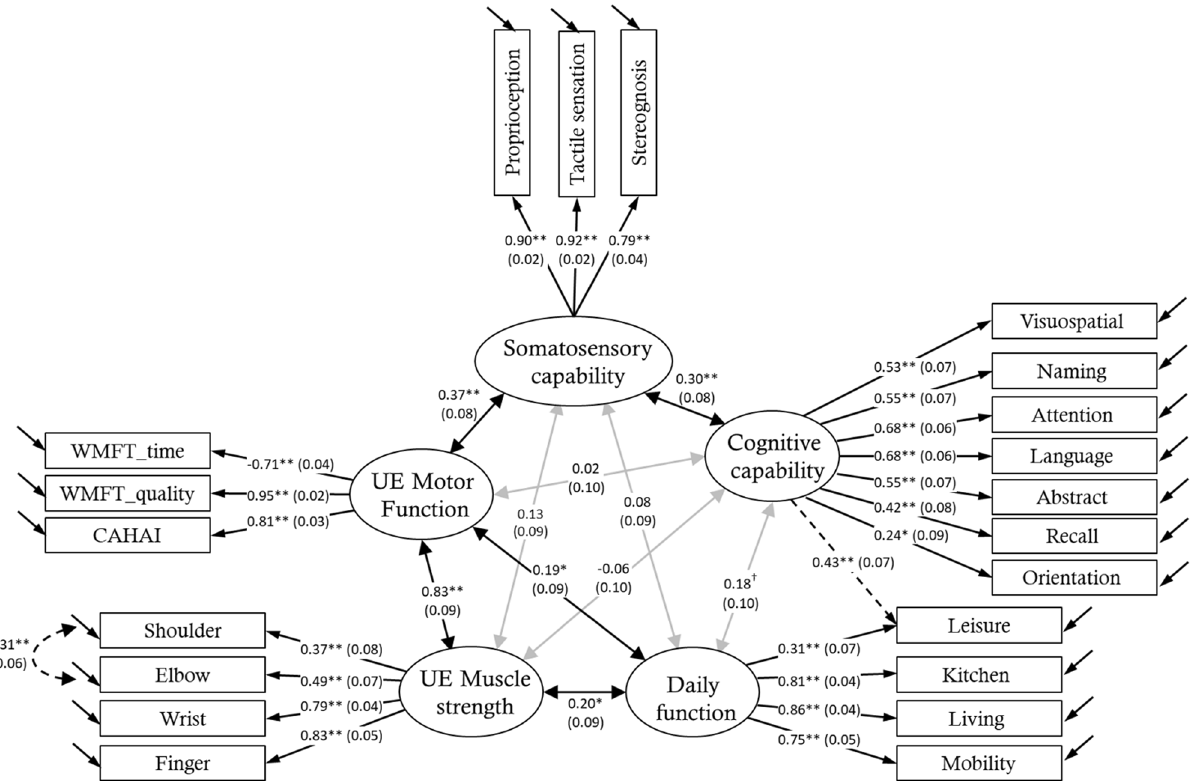
Figure 1. Confirmatory factor analysis of the modified measurement model. Latent constructs of five abilities (somatosensory capability, cognitive capability, UE muscle strength, UE motor function, and independence in daily function) are represented with circles and variables that measured each ability are represented with squares. Values of standardized results are shown and the standard errors are shown in the parentheses. Single- headed arrows indicate direct relationships, while double-headed arrows indicate the correlations between variables. Dark lines indicate statistically significant results, and gray lines indicate insignificant results. The dotted lines indicate the additional parameters recommended by the LM test, which indicate that the leisure activity can represent the latent constructs of both cognitive capability and independence in daily function, and measured variables of shoulder and elbow muscle are significantly correlated. † P < 0.10; * P < 0.05; ** P < 0.001. WMFT: Wolf Motor Function Test; CAHAI: Chedoke Arm and the Hand Activity